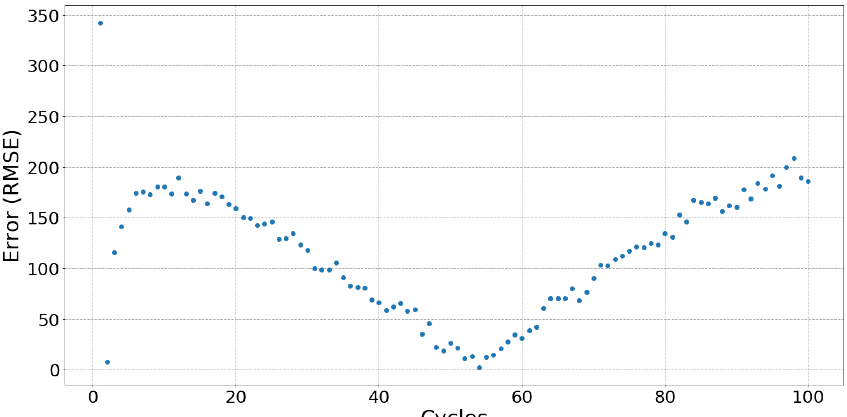
Figure 9. The error between each cycle of stretch and the fitted line of Sample 15. This shows the best repeatability result from all the samples‘ stretch and relax.